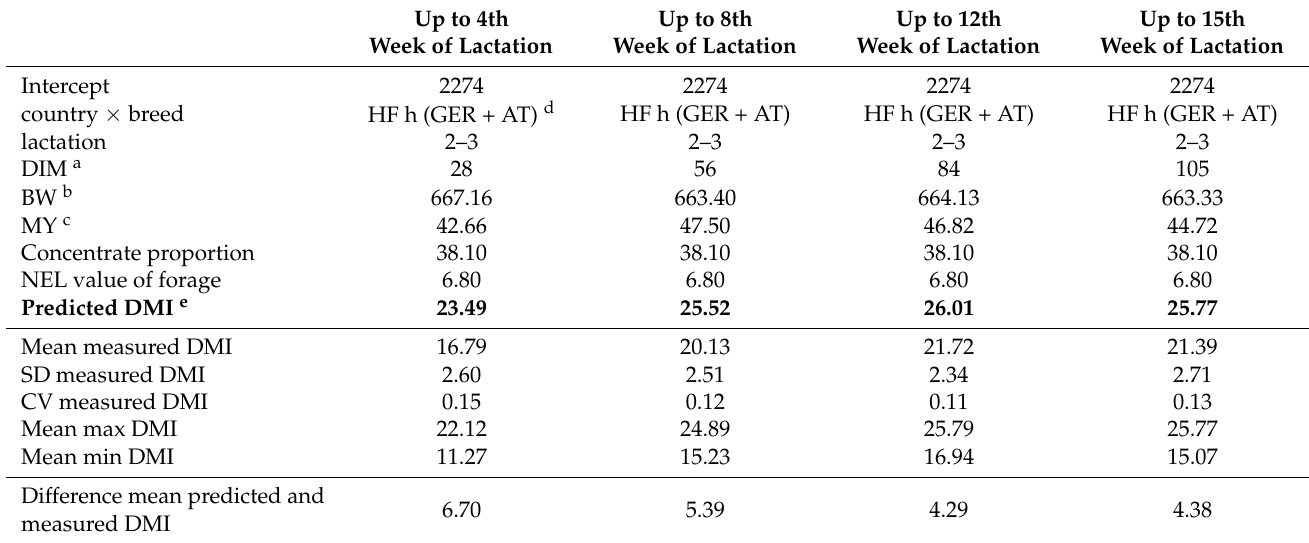
Table 2. Predicted DMI vs. measured DMI during different stage of early lactation ( n = 28).